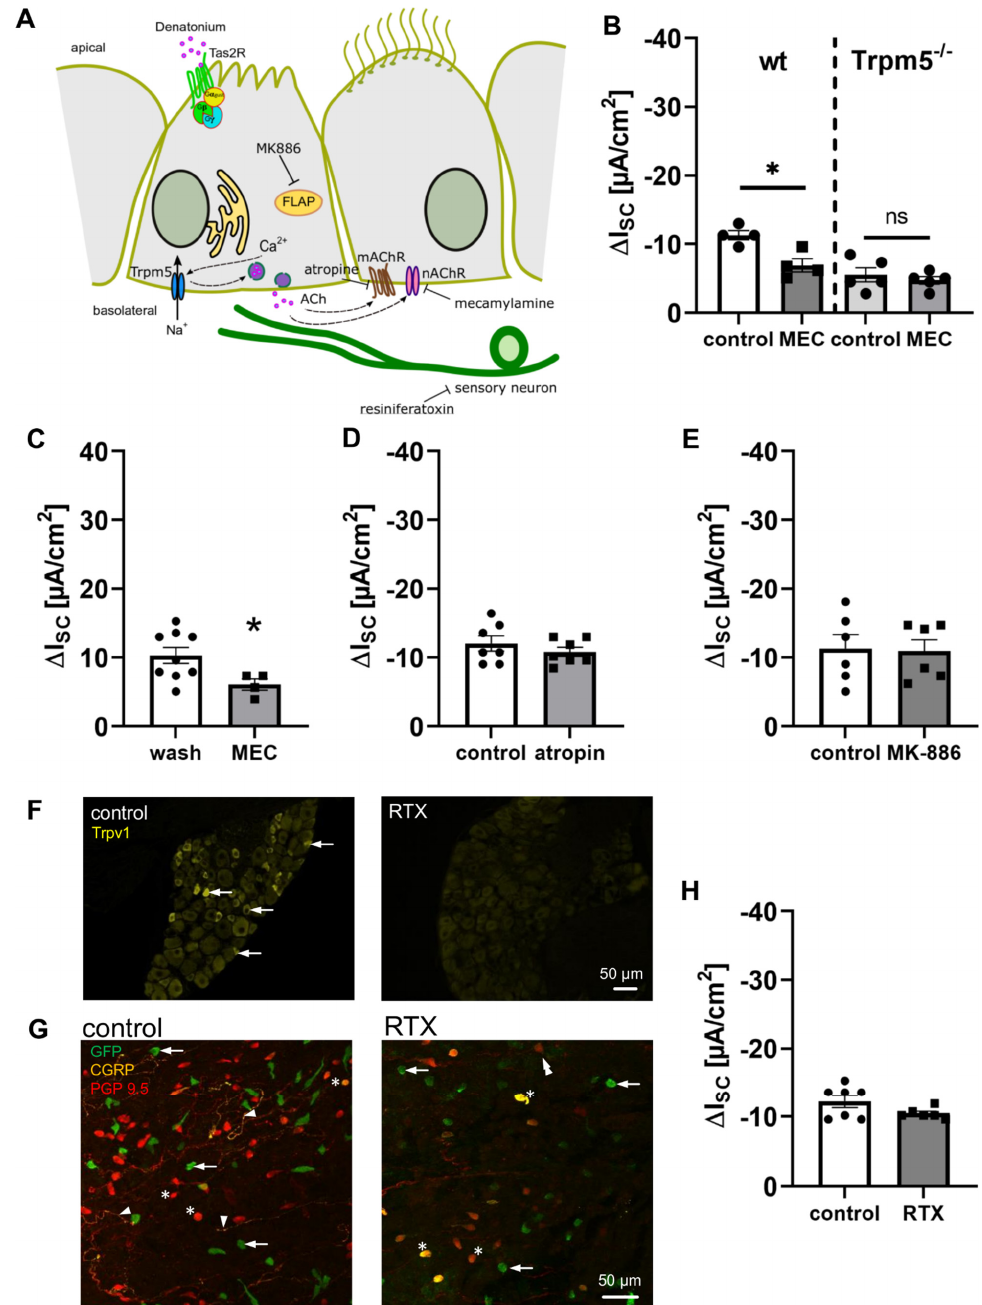
Figure 6. Cholinergic signalling is involved in the denatonium-induced effect. ( A ) Schematic drawing of the influence of the muscarinic ACh receptor inhibitor atropine, the nicotinic ACh receptor inhibitor mecamylamine, the FLAP antagonist MK-886, and the TRPV1 agonist resiniferatoxin. ( B ) In the presence of the nAChR antagonist mecamylamine (MEC, 25 µ M, apical and basolateral), the denatonium-induced effect was significantly reduced in wildtype but not in Trpm5 − / − mice ( ∆ I SC , n = 4–5, * p < 0.05, ns: not significant). ( C ) Application of MEC (25 µ M, apical and basolateral) in the presence of denatonium (1 mM, apical) increased I SC , but to a lesser extent than the wash out of denatonium. ( D ) The mAChR antagonist atropine (50 µ M, apical and basolateral) did not influence the denatonium-induced current ( ∆ I SC , n = 5). ( E ) The FLAP inhibitor MK-886 (1 µ M, apical and basolateral) did not alter the denatonium-induced effect ( ∆ I SC , n = 6). ( F ) Immunostaining of DRG sections from an untreated and an RTX-treated wildtype mouse stained for Trpv1 (arrows: Trpv1 + neurons). ( G ) Immunostaining of a tracheal whole mount preparation of an untreated trachea from